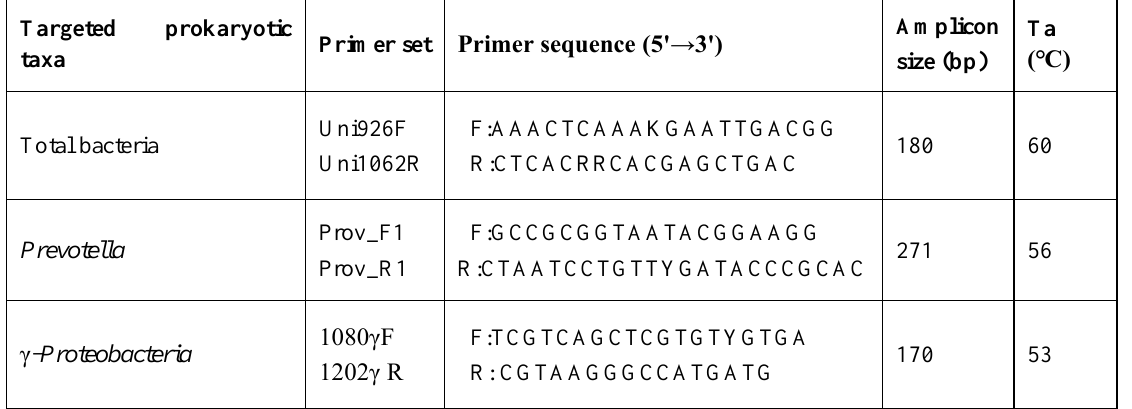
Table 1. List of primers used for quantification of extracted DNA by real time PCR.